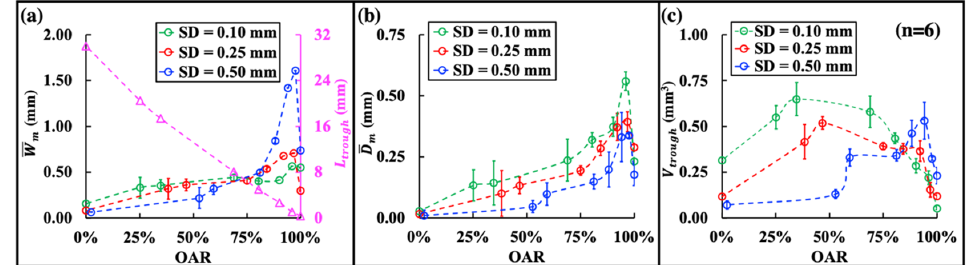
Figure 7. ( a ) Total trough length ( L trough ) (small purple triangles) and mean width ( W m ) (small circles in different colors), ( b ) mean depth ( D m ), and ( c ) volume ( V trough ) of the damage trough vs. the overlapping area ratio (OAR) between the successive laser pulses.